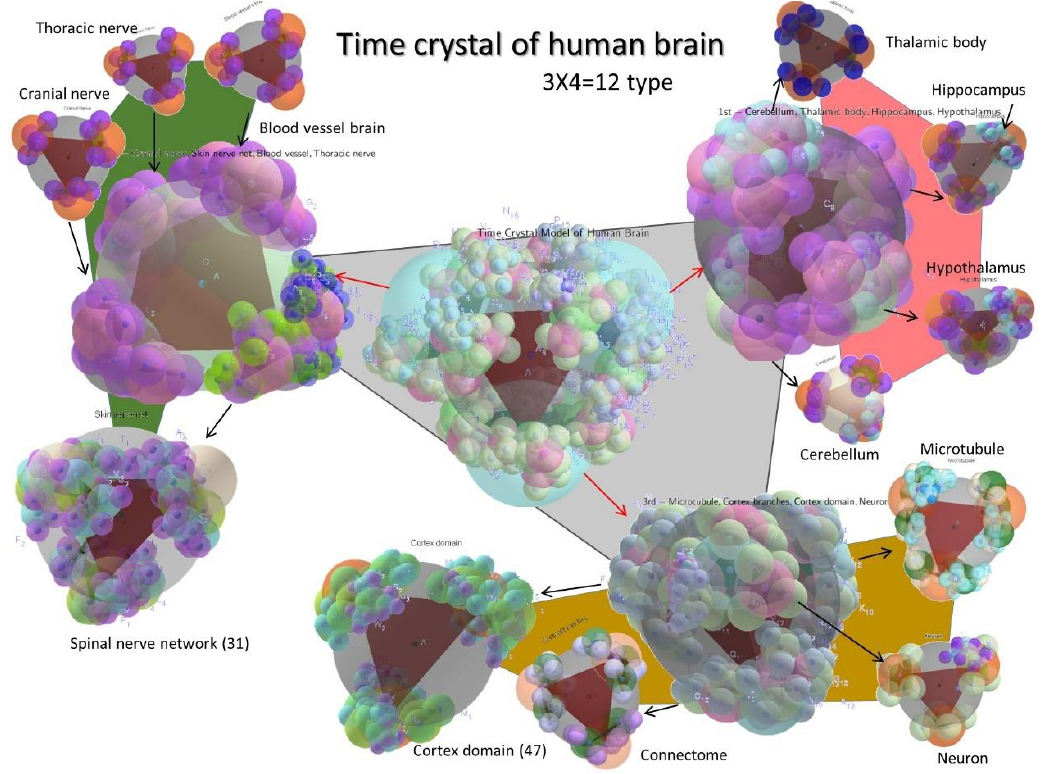
Figure 14. 3D time crystal model for the complete human brain, it is made of 12 components [41]. Information 2020 , 11 , x FOR PEER REVIEW